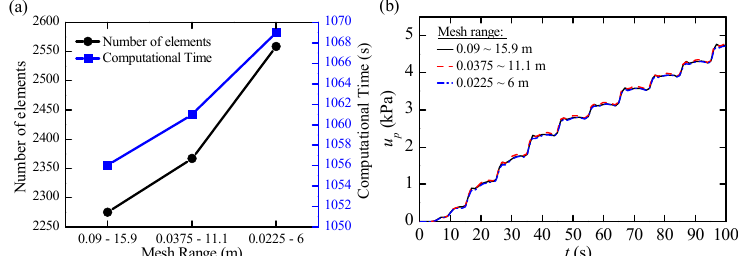
Figure 3. Comparison between different mesh sizes for COMSOL Multiphysics in terms of ( a ) the number of elements and the computational time, and ( b ) residual pore pressure, u p at a duration of 100 s.